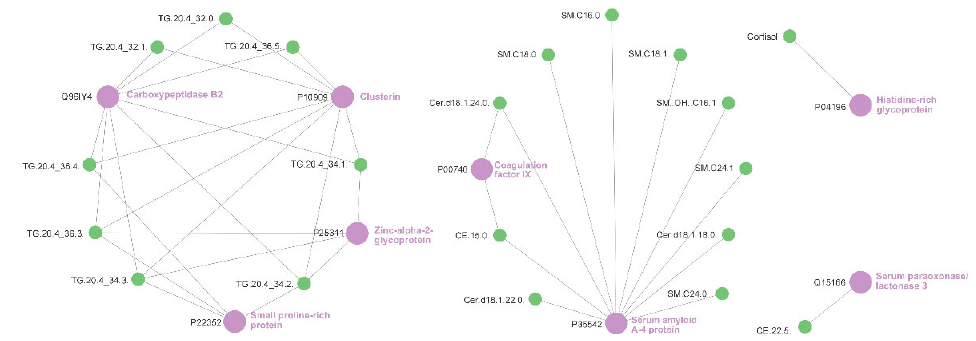
Figure 4. Relevance network analysis of features. The network shows those features identified as differentially expressed between COVID-19-positive participants treated with glucocorticoids and those not treated with glucocorticoids. Metabolites are shown as green nodes and proteins are shown as purple nodes. Generated in CytoScape from a network produced in the MixOmics R package. Links between nodes are presented for readability and are not proportional to significance or